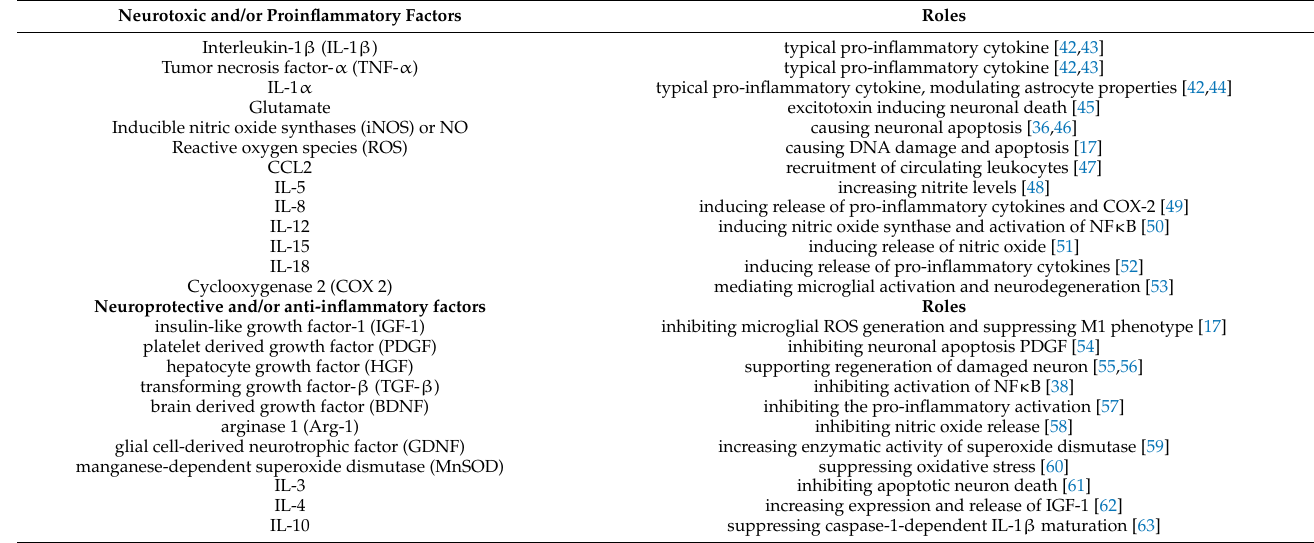
Table 1. A list of neurotoxic and neuroprotective factors released by microglia. Neurotoxic and/or Proinflammatory Factors Roles Interleukin-1 β (IL-1 β